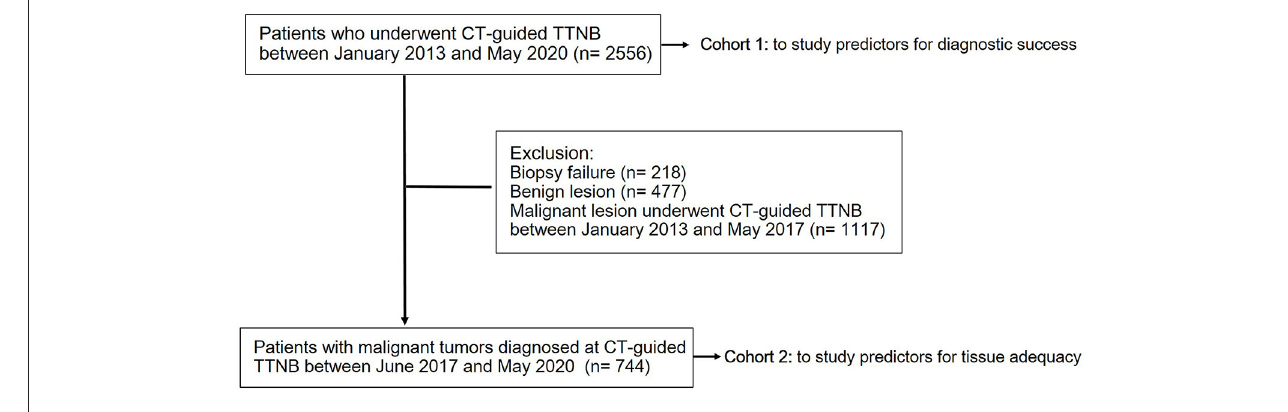
FIGURE 1 | Flow diagram of patient selection.